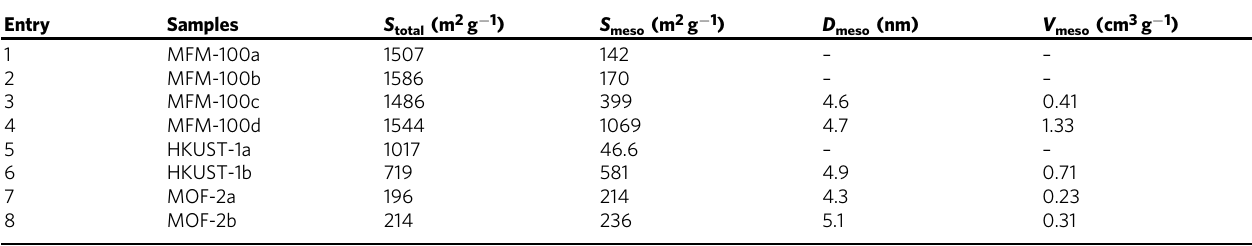
Table 1 Summary of the porosity of all MOFs in this